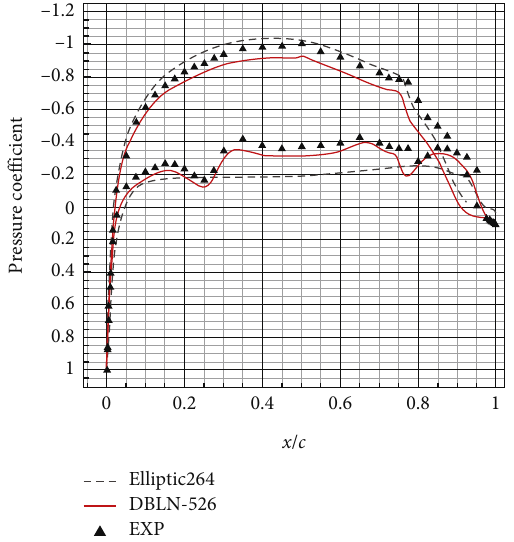
Figure 15: Lower surface transition position ( Re = 0 : 8 E 6 ).